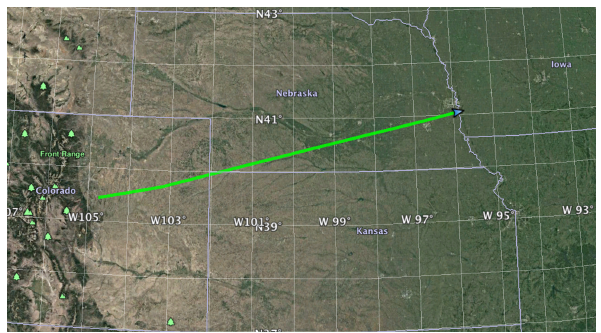
Figure 16. Map of the segment of the west-to east flight track ana- lyzed for 2014 SF3 on 25 August 2014 approaching Iowa.